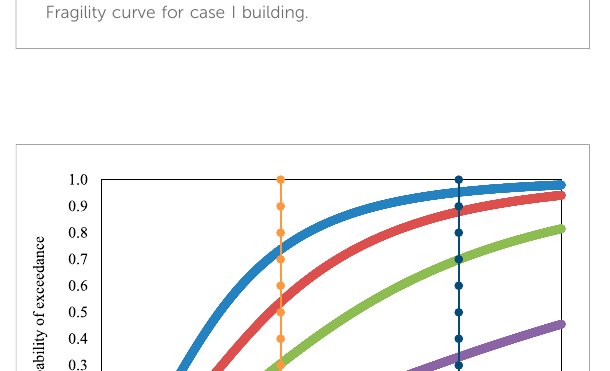
FIGURE 2 Fragility curve for case I building.